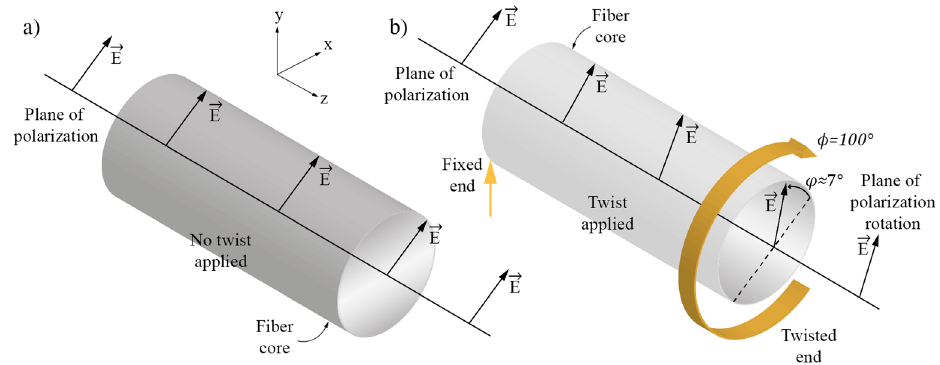
Figure 1. ( a ) Polarization plane and fiber direction when fiber is not twisted and ( b ) When fiber is twisted through 100°, the polarization plane is rotated through 7° in the opposite direction.